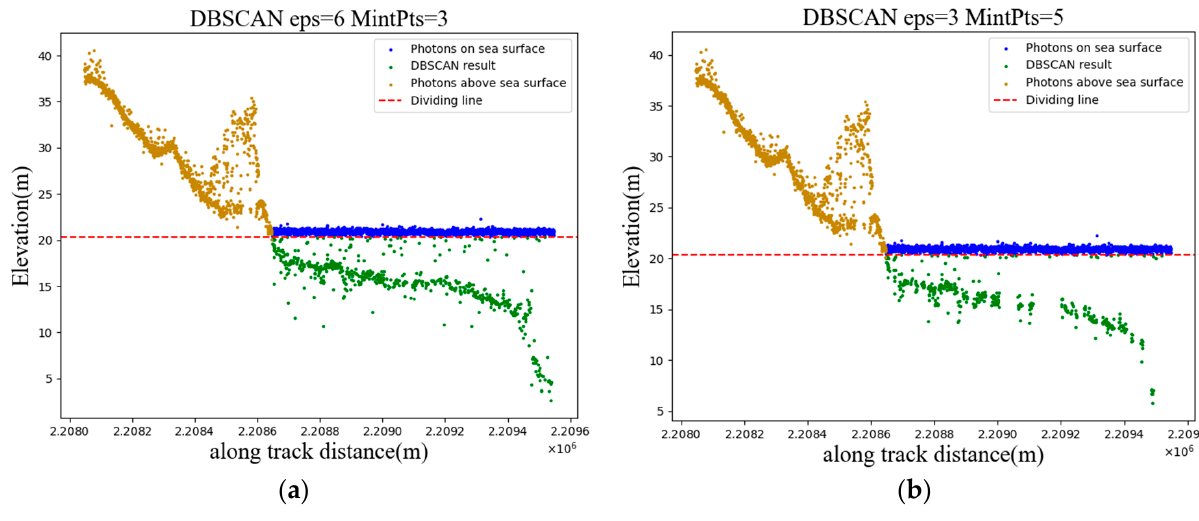
Figure 6. ( a ) DBSCAN denoising graph with “loose” parameter settings (eps = 6, MintPts = 3); ( b ) DBSCAN denoising graph with “strict” parameter settings (eps = 3, MintPts = 5).